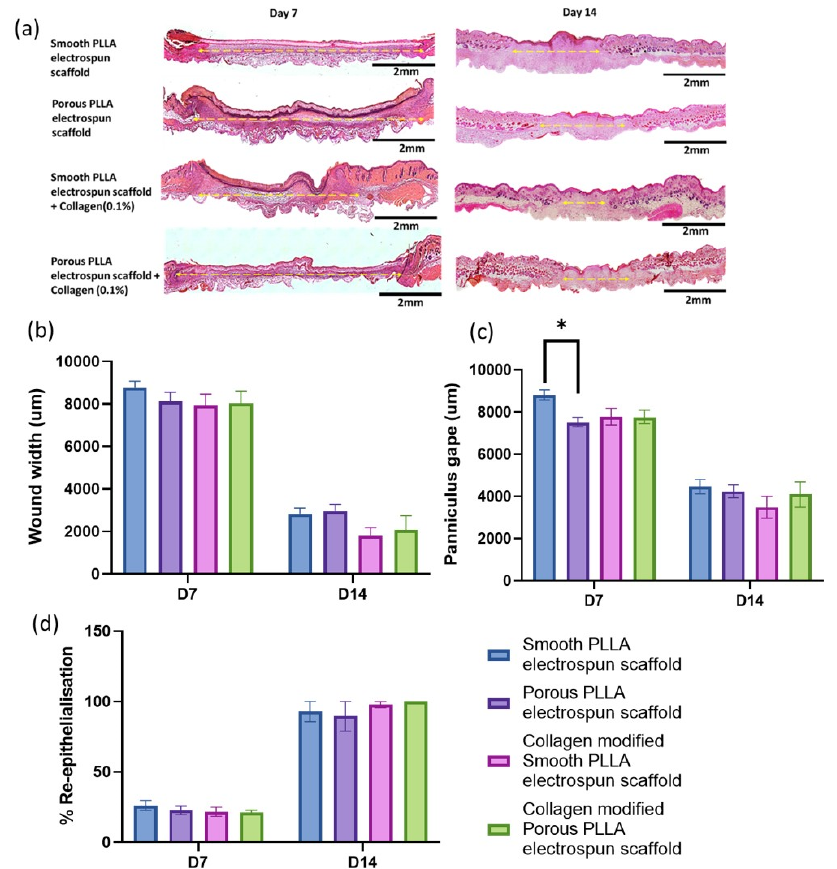
Figure 4. ( a ) Representative images of smooth PLLA electrospun scaffold, porous PLLA electrospun scaffold, smooth PLLA electrospun scaffold + collagen (0.1%) and porous PLLA electrospun scaffold + collagen (0.1%) wound sections after H&E staining at days 7 and 14 of healing. Images captured at 10 × objective. Scale bar = 2 mm. Yellow dashed lines indicate wound width measured. The histological analysis of wounds demonstrates decreased microscopic wound width ( b ) and decreased panniculus gape ( c ) and increased average re-epithelialisation ( d ) in scaffold treated wounds. All data are represented as mean ± SEM, n = 6 mice, * = 0.03.